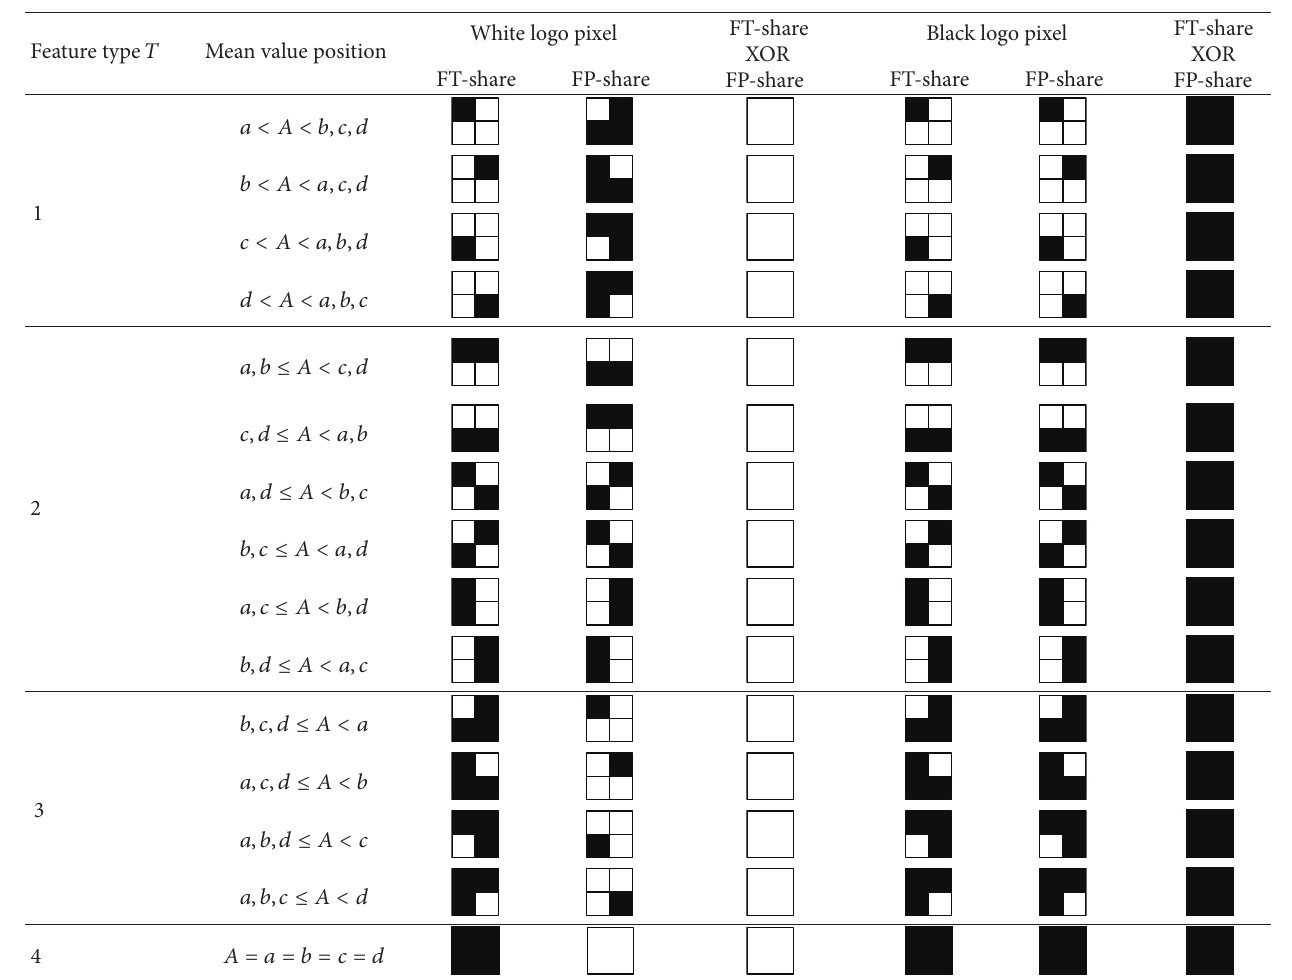
Algorithm 1: Feature extraction. Table 1: The mapping